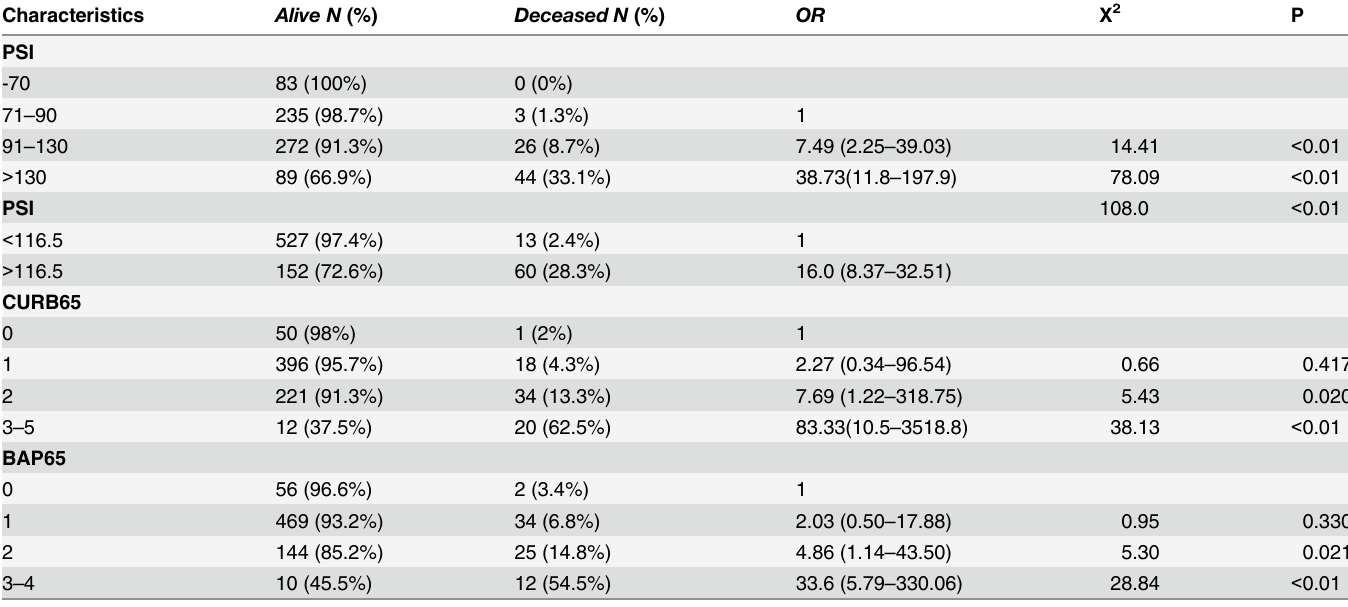
Table 4. In-hospital mortality according to the PSI, CURB65 and BAP65 score and risk groups for AECOPD. Characteristics